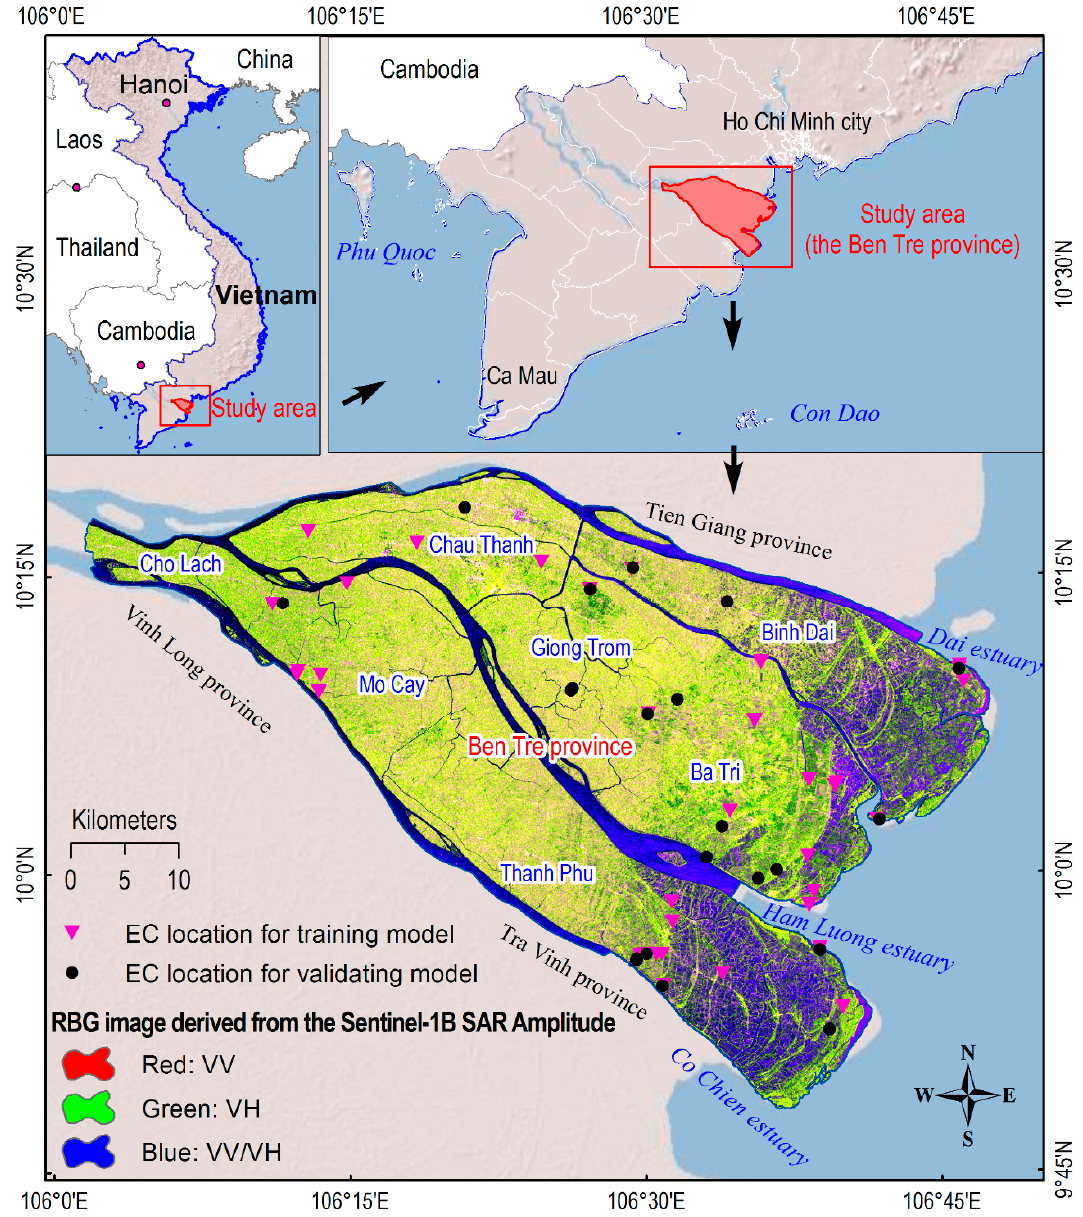
Figure 1. Location of the Ben Tre province and the soil sample (electrical conductivity—EC) for training and validating models.